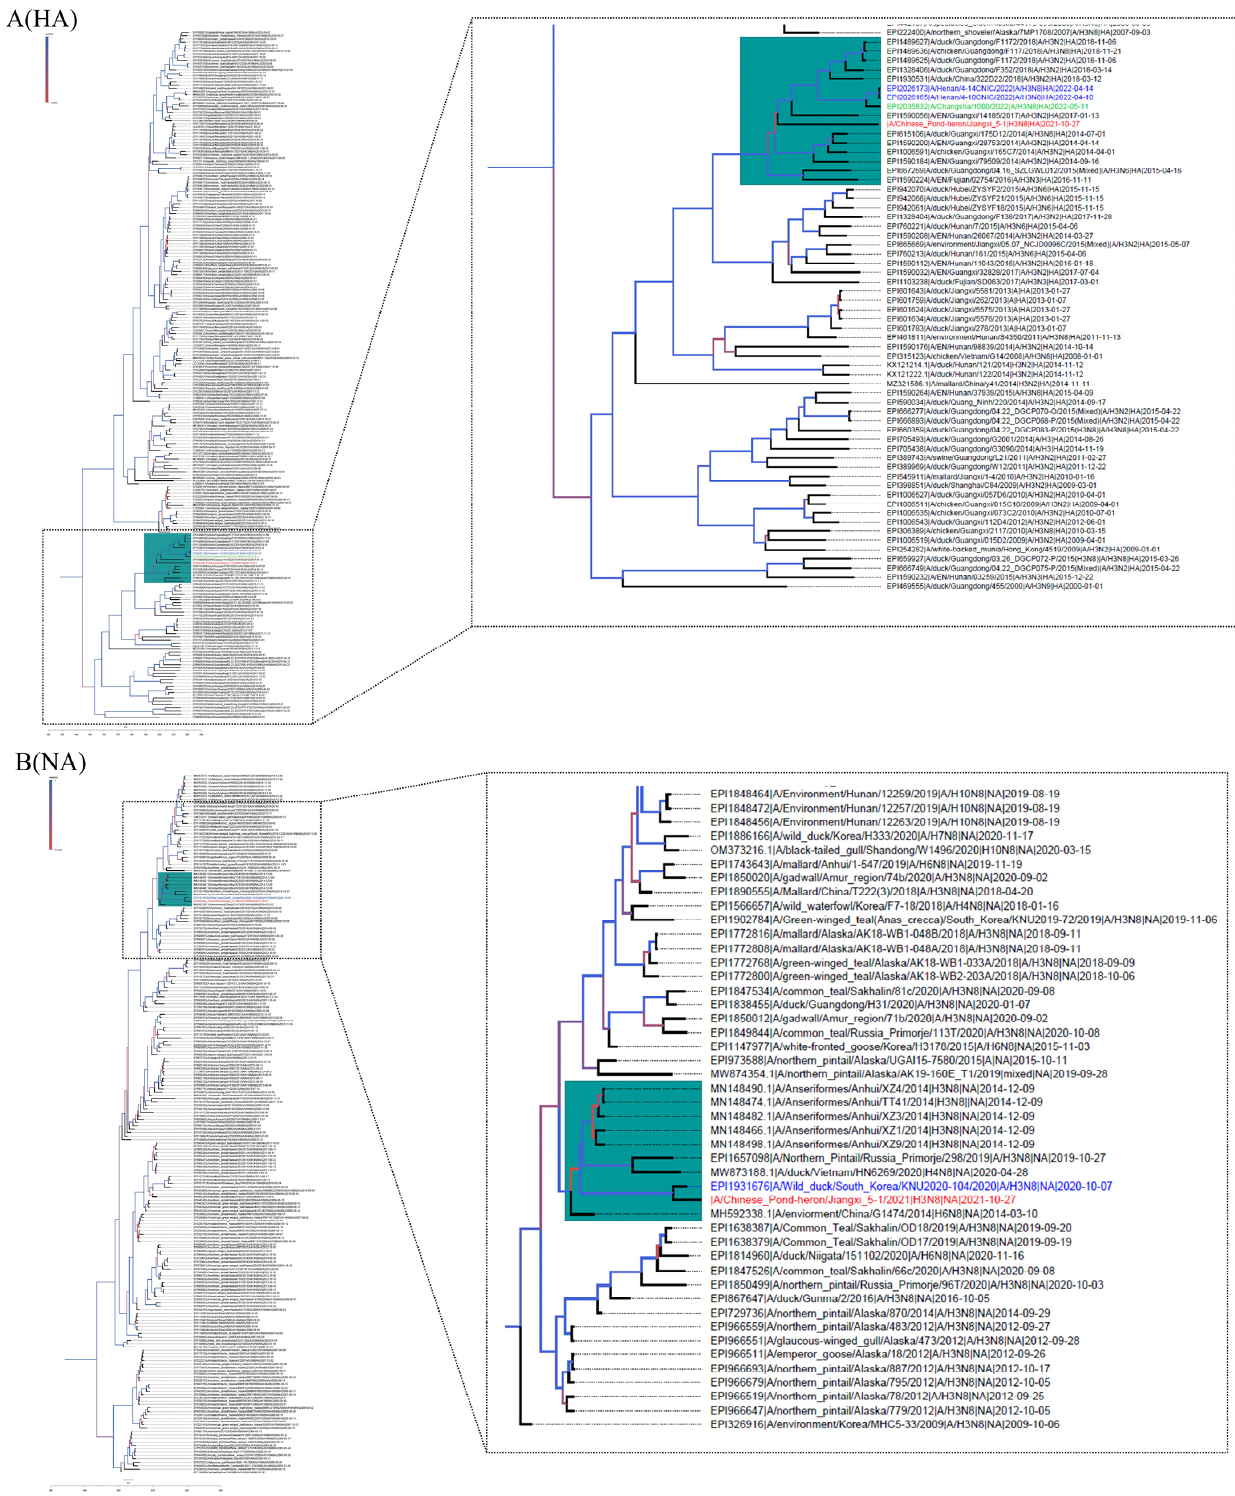
Figure 1. Phylogenetic analysis of HA ( A ), NA ( B ) of JX 5-1. The phylogenetic trees were constructed using gene sequences identified in NCBI or GISAID Blast analyses. JX 5-1 is marked in red, the closest related sequence is marked in blue. The trees were built using BEAST (v1.8.4) and illustrated using FigTree (v1.4.2).